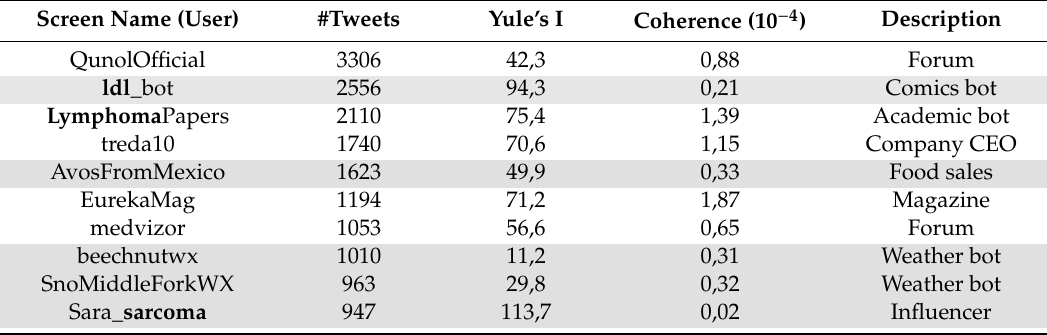
Table 2. Top-10 users’ quality metrics. In the screen names column, stream keywords are in bold face. Shadowed rows correspond to out-of-domain users.